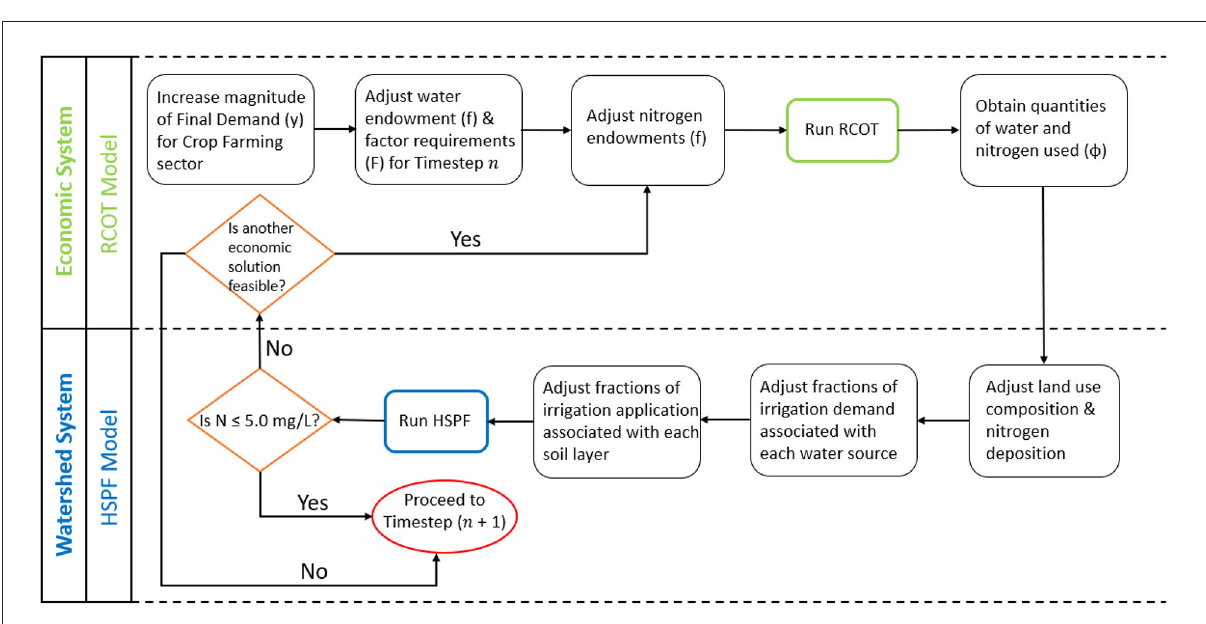
FIGURE3 Decision tree representing steps taken within RCOT and HSPF during Timestep ( n